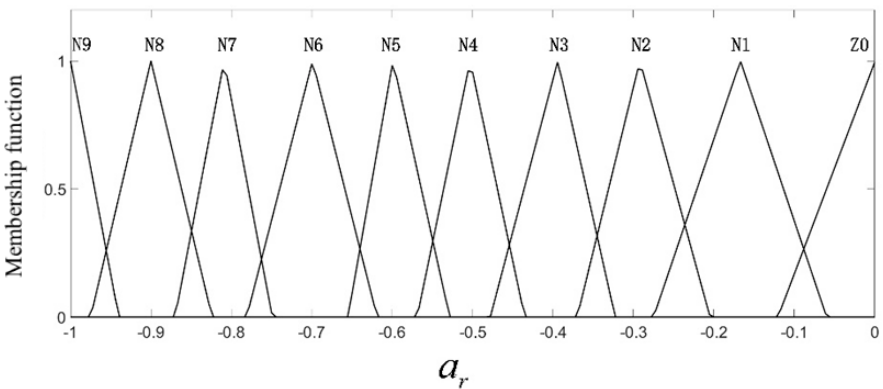
Figure 10. The membership function of the longitudinal relative velocity.